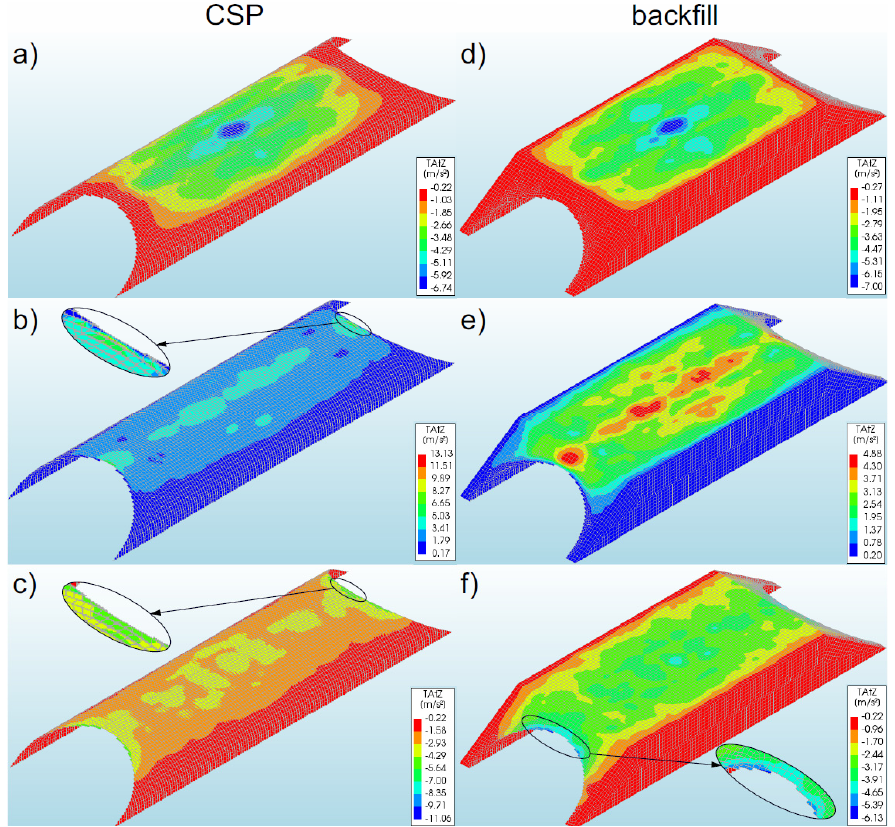
Figure 20. Distribution of maximum accelerations for bridge #I in the shell and backfill for model 1 ( a , d ), model 2 ( b , e ), and model 3 ( c , f ). ( a , d ), model 2 ( b , e ), and model 3 ( c , f